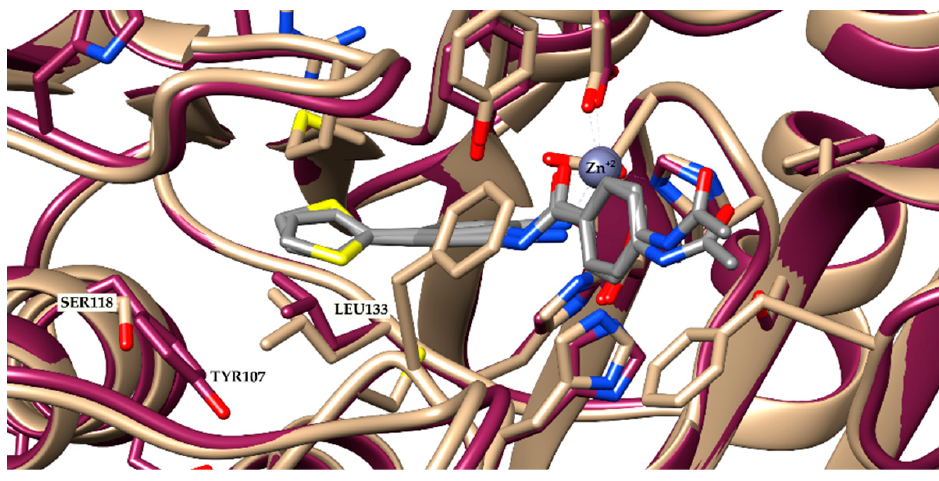
Figure 3. Superposition of HDAC-2 (beige) and 3 (purple). In grey—a co-crystallized ligand from HDAC-2 (PDB ID: 4LY1).